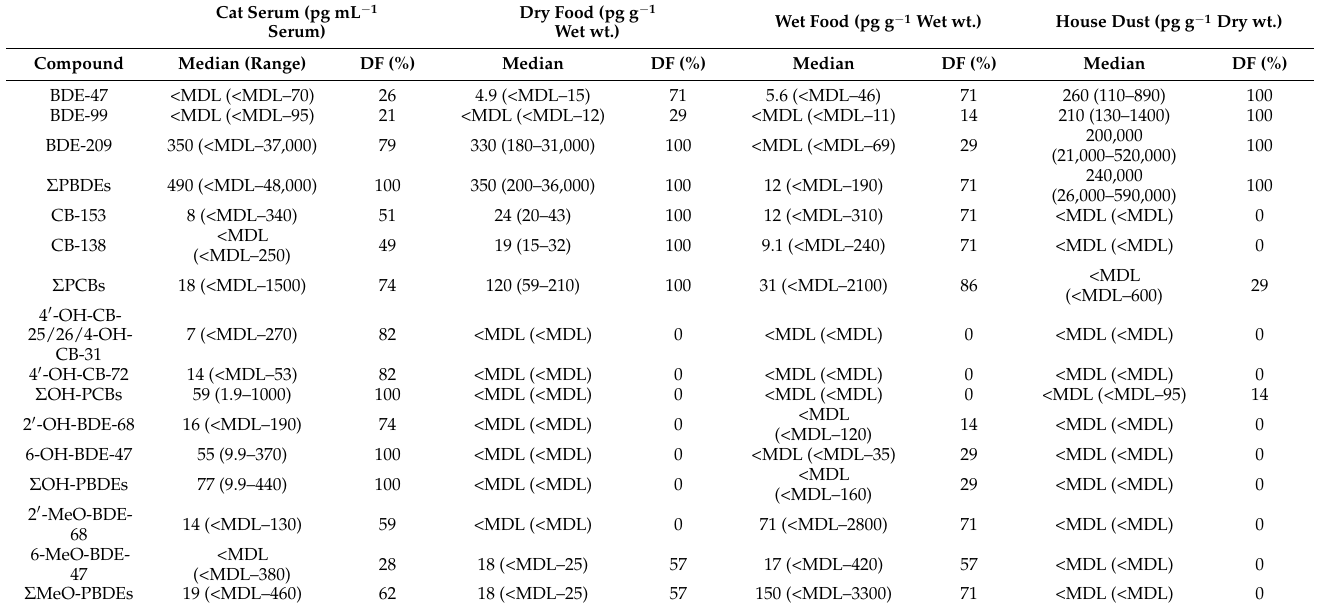
Table 3. OHC concentration in cat serum, cat food, and house dust.